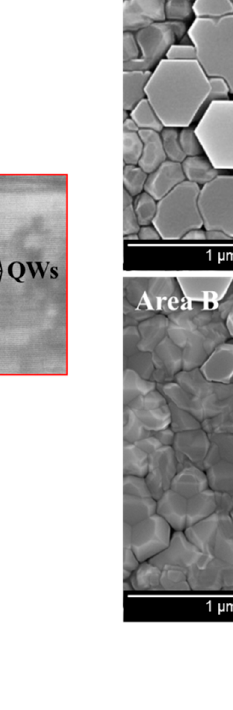
Figure 2. Cross-section SEM and Z-contrast scanning transmission mode (STEM) (inset) images ( a ) and plane-view SEM images ( b ) of the LED NWs. Two types of NWs can be easy distinguished: those with flat sides and hexagonal tops with sharp edges, and those which are “oval-like”, with less regular, rough tops and rounded edges. Due to the temperature gradient across the substrate, the ratio of these two types varied. Two types coexist in area A, while in area B, NWs with rounded tops are mainly present.